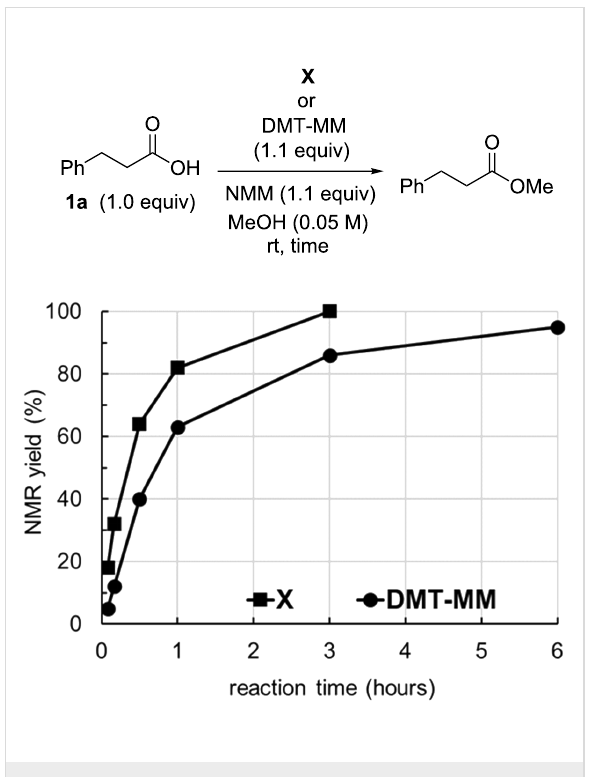
Figure 3: Time courses of the basic Fischer-type